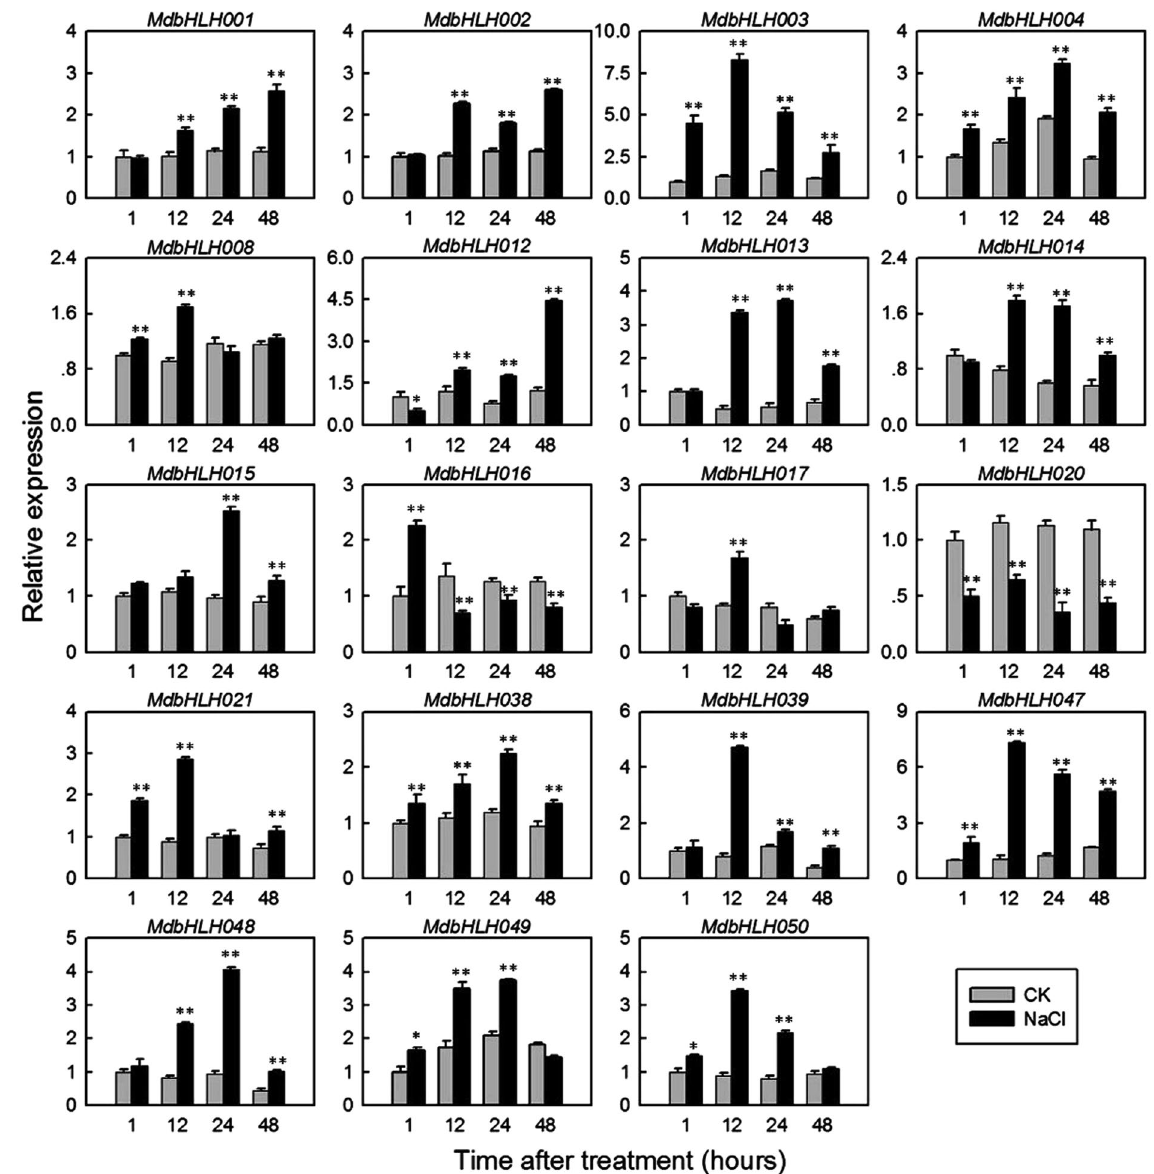
Figure 7. qRT-PCR analysis of 19 MdbHLH genes in response to salt stress. The expression levels were normalized to 1 h CK (check; deionized water) sample. Samples were harvested at 1 h, 12 h, 24 h and 48 h after 250 mM NaCl treatment or CK. Mean values and SDs were obtained from three biological and three technical replicates. Asterisks indicate the corresponding gene was significantly up- or downregulated under salt treatment (t-test; * P < 0.05, ** P <